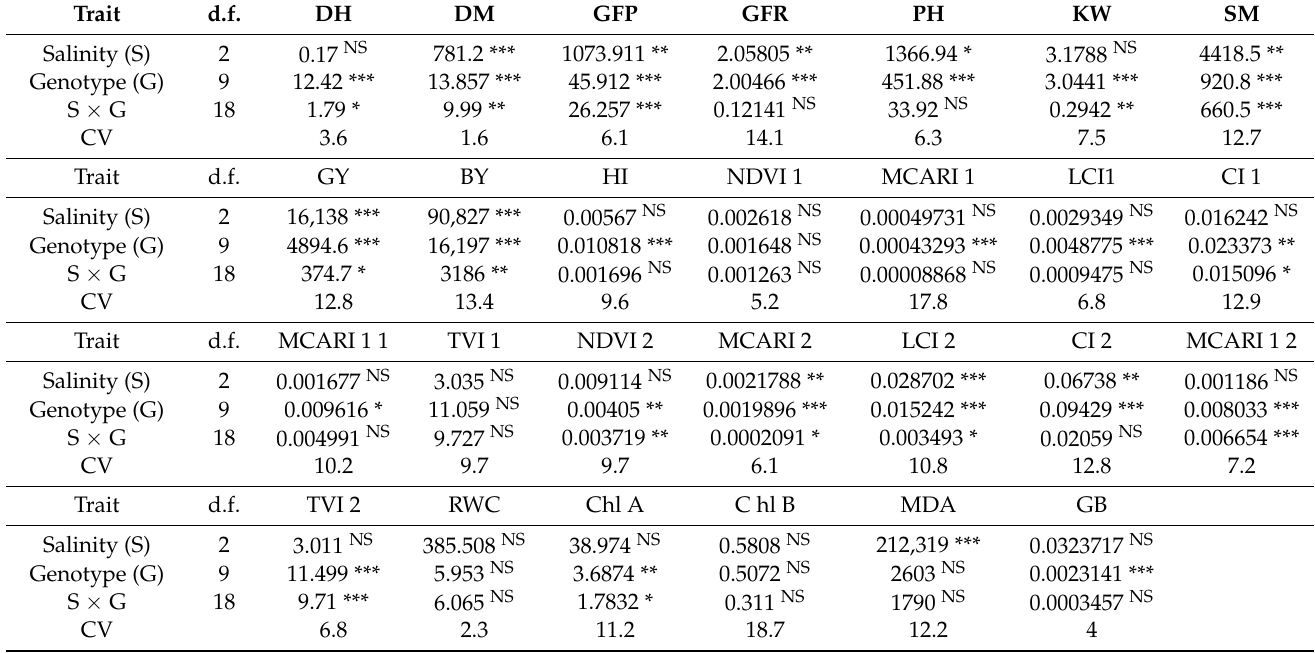
Figure 9 and Table 8 show the grain yield gm per row (GY) mean performance of ten genotypes evaluated in a simulated lysimeter and irrigated with 0.4, 6.0, and 12.0 dS/m diluted seawater. The data represent genotypes classified into two categories, i.e., genotypes 1, 2, 3, 4, 5, 6, and 9 (Misr 4) recorded as high performance, while the old varieties, i.e., genotypes 7 (Kharchia 65), 8 (Oasis F86), and 10 (Sakha 8) under 3 saline irrigation were not. In addition, in the combined analysis, genotypes, 1 and 2 recorded the highest values of 133.3 and 133.8 g, respectively. However, varieties 7, 8, and 10 had 79.6, 79.1, and 78.9, respectively, shown in Table